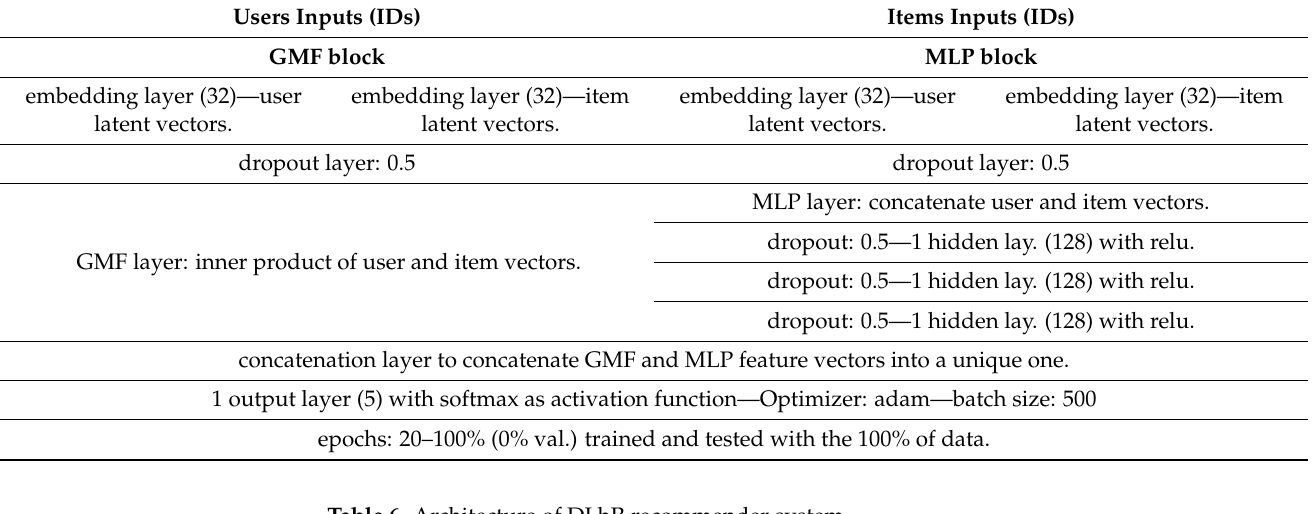
Table 6. Architecture of DLbR recommender